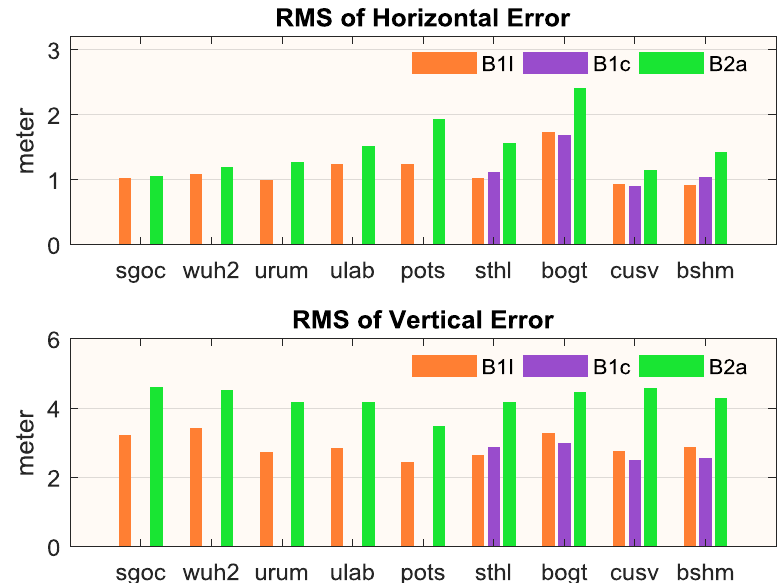
Figure 10. RMS of SPP performance of B1I, B1c and B2a at horizontal ( upper ) and vertical ( lower ) component (BDS-3-only, one week).